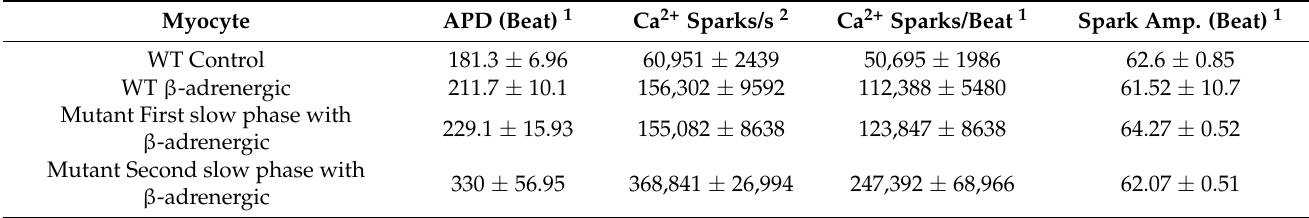
Table 5. Action potential amplitudes, duration, and number of sparks in alternate beats.